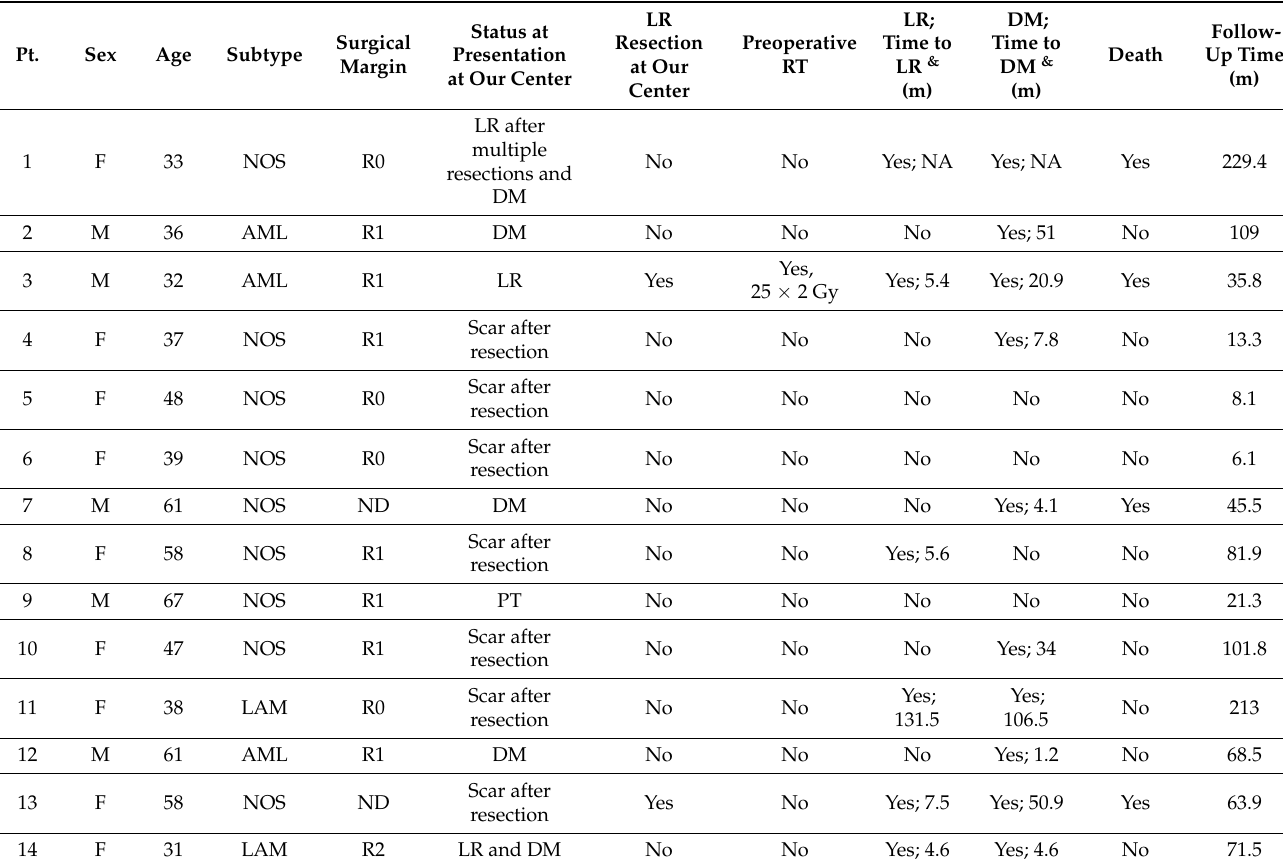
Table 2. The clinical course of the disease of patients treated surgically for PEComa outside of the reference sarcoma center.